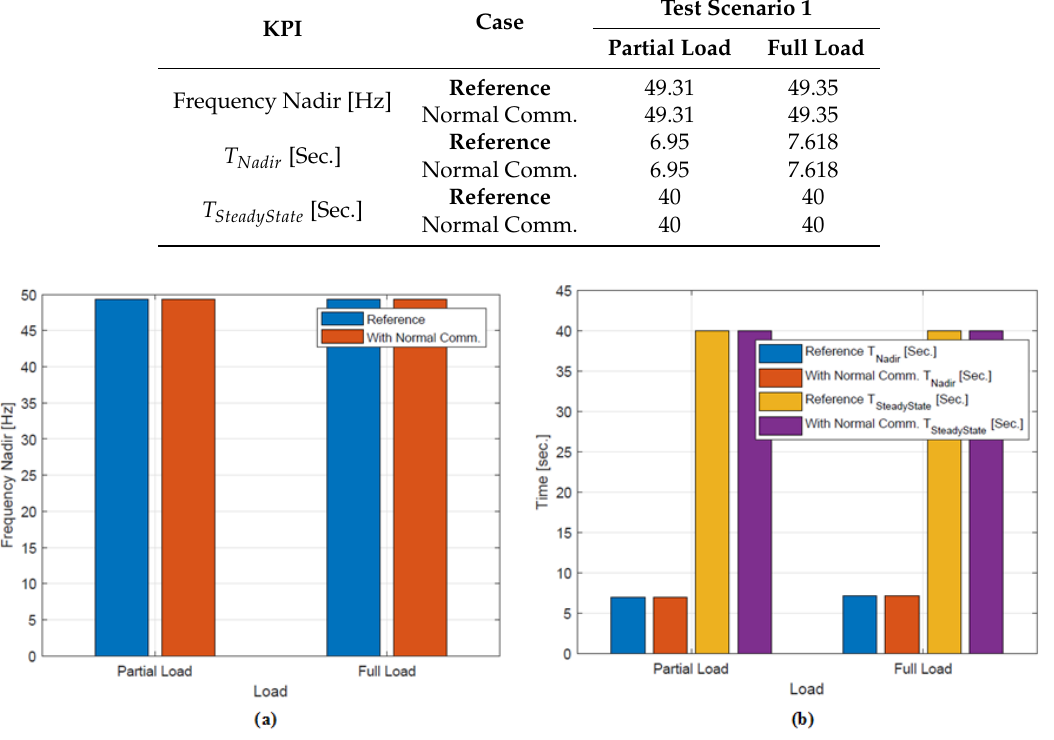
Figure 11. Comparison of ( a ) f Nadir , ( b ) T Nadir and T SteadyState obtained in Test Case -1 with that of Reference Frequency Response.